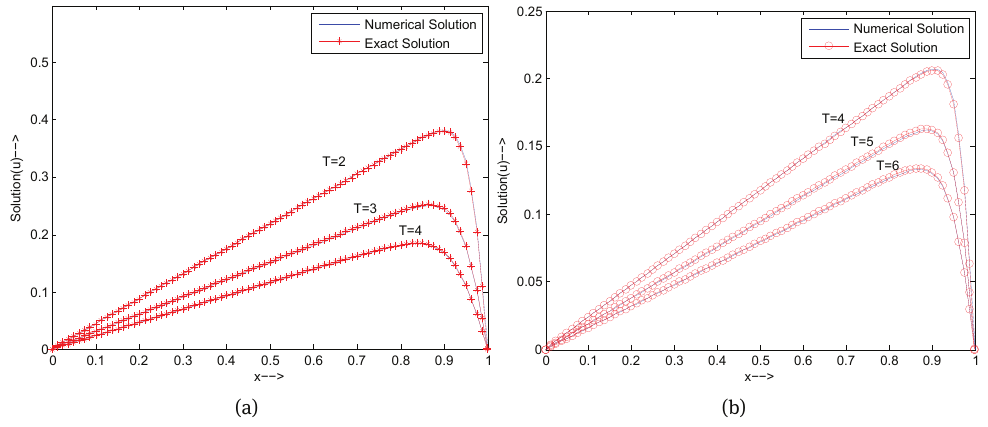
Fig. 7: Numerical solutions of Example 2 at different times for Δx = 0.0125 and different values of ν and Δt , (a) ν = 0.01 , Δt = 0.001 (b) ν = 0.005 , Δt = 0.001 .